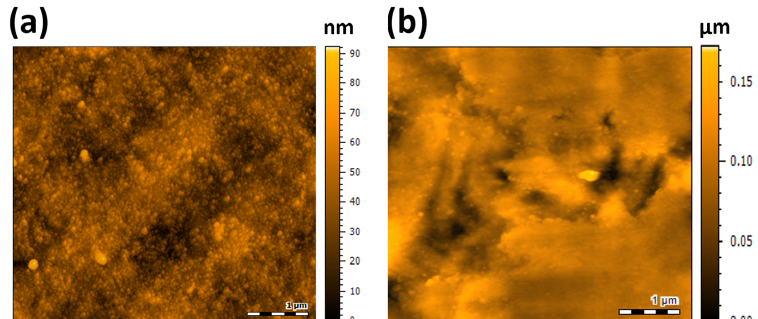
Figure 8. AFM topographical analysis of the surface of ( a ) a 100 nm SDP ‐ Y 2 O 3 film ( b ) the reference unpolished stainless steel raw substrate provided directly from Bruker